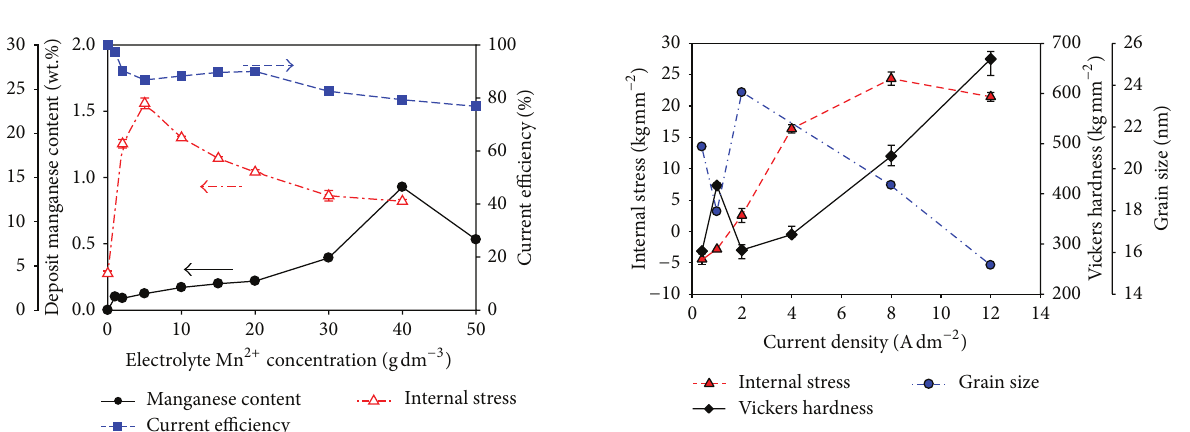
Figure 1: The properties of Ni-Mn coating prepared in electrolyte with varying Mn 2+ concentration but constant current density of 8 A/dm 2 .